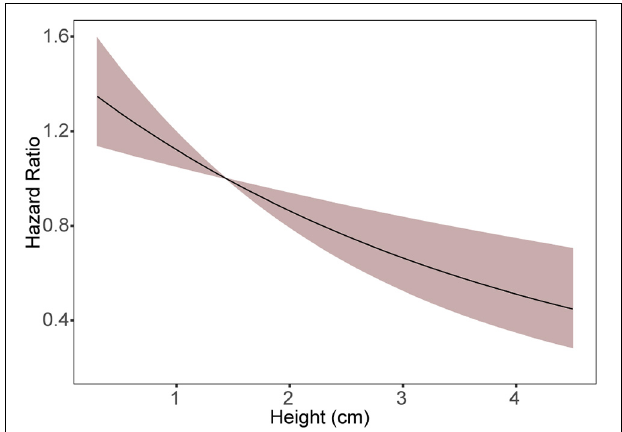
FIGURE 7 | Proportional Hazard Ratio as a function of colonial recruit height. The Hazard ratio = 1 (equal hazard) when recruits height equals the mean height (1.1